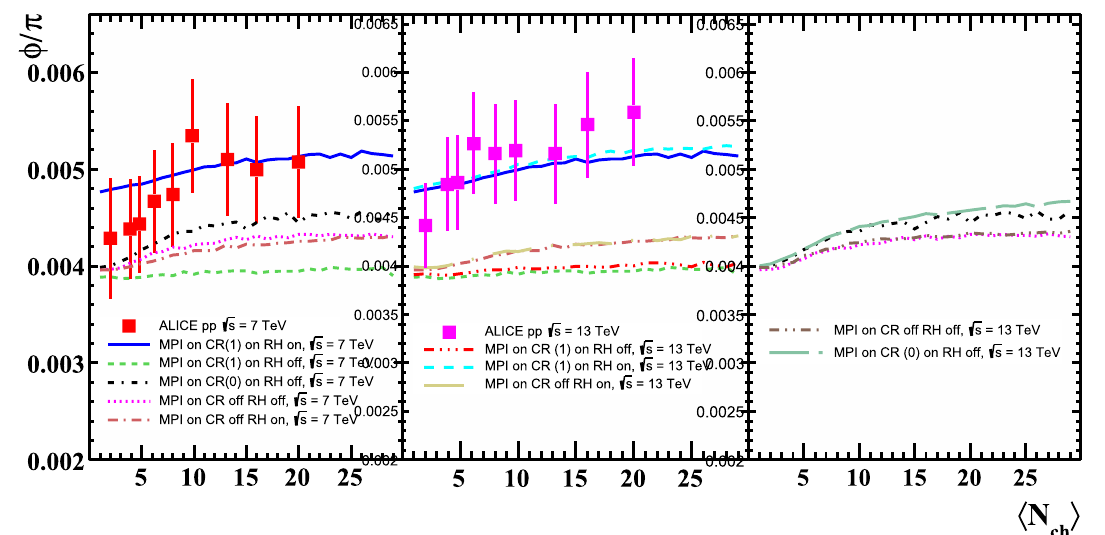
√ s = 7 RH. (Right panel) Comparison of ratios for p–p collisions at TeV and 13 TeV for two other modes, namely CR-off and CR(0) with- out RH. The solid squares show the multiplicity dependence of φ/ K √ s = 7 TeV and 13 TeV as obtained by and φ/π for p–p collisions at the ALICE experiment